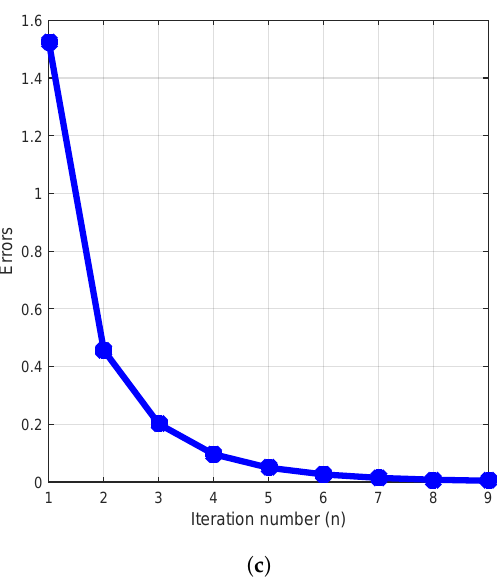
Figure 1. Errors vs. iteration numbers (n) for Example 1: case 1 ( a ); case 2 ( b ); case 3 ( c